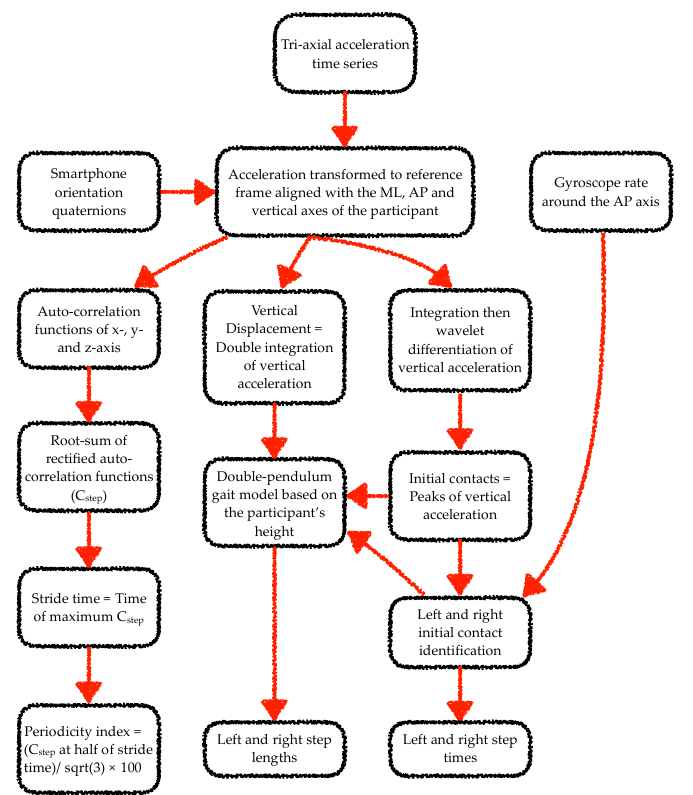
Figure 2. Flow chart of the steps involved in processing of smartphone data from each 6-s walking trial of the gait tasks. Note: ML and AP stand for mediolateral and anterior–posterior, respectively.